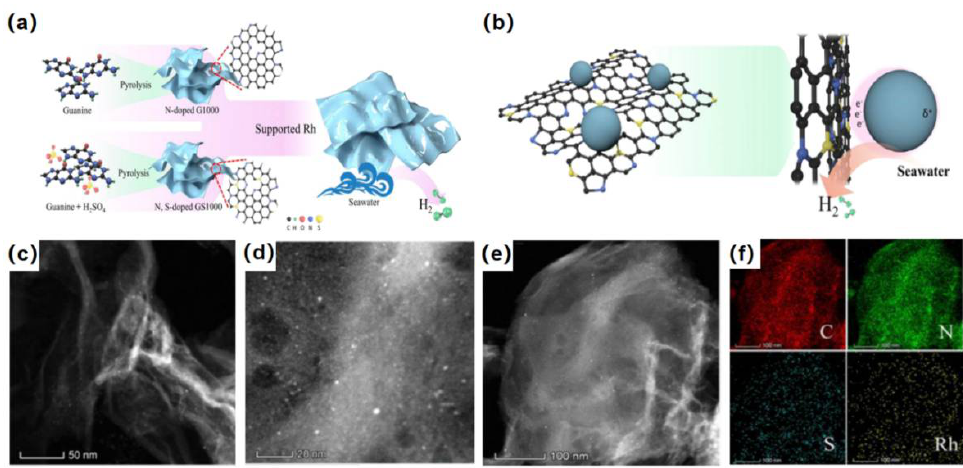
Figure 6. ( a ) Schematic diagram of the synthesis of Rh-G1000 and Rh-GS1000, ( b ) schematic diagram between Rh and carbon support, ( c – e ) HAADF-STEM of 0.5Rh-GS1000, and ( f ) elemental mapping of 0.5Rh-GS1000. Reproduced with permission from [93]. Copyright © 2019, American Chemical Society.